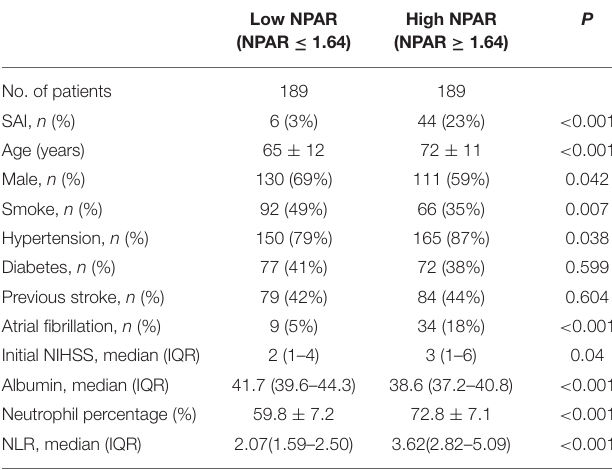
TABLE 3 | Baseline characteristics of AIS patients with low and high